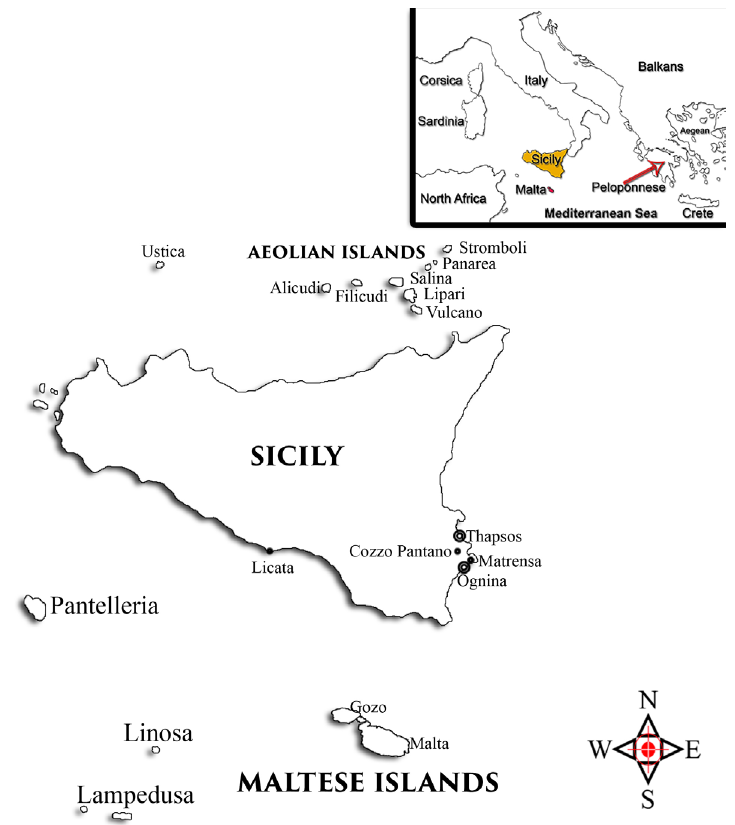
Figure 1. Map of the location of the Maltese archipelago within the Mediterranean and archaeological sites included in this